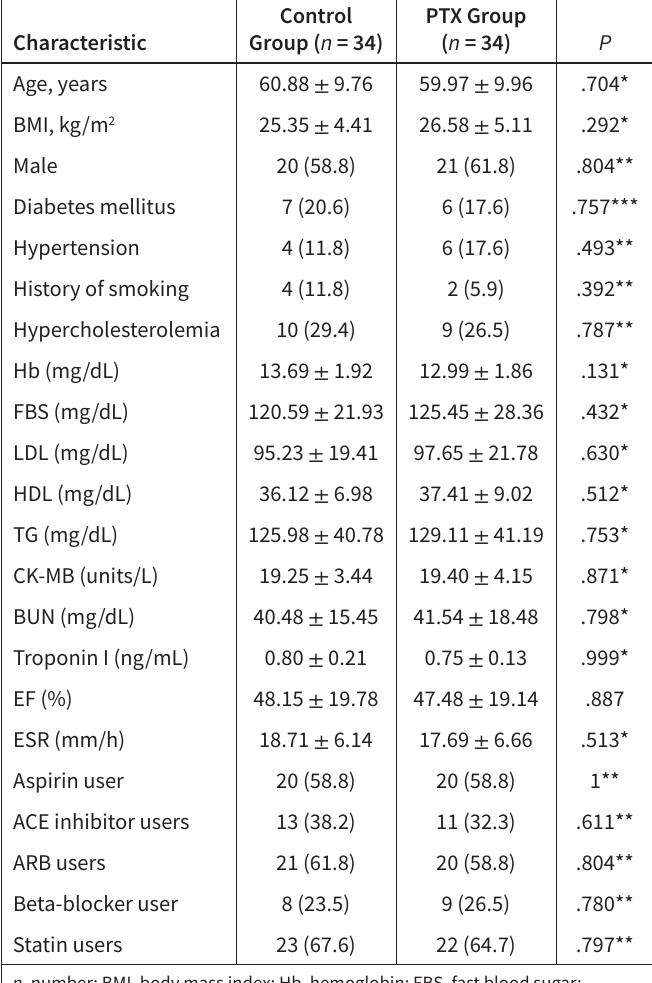
Table 1. Baseline Clinical Characteristics of Enrolled